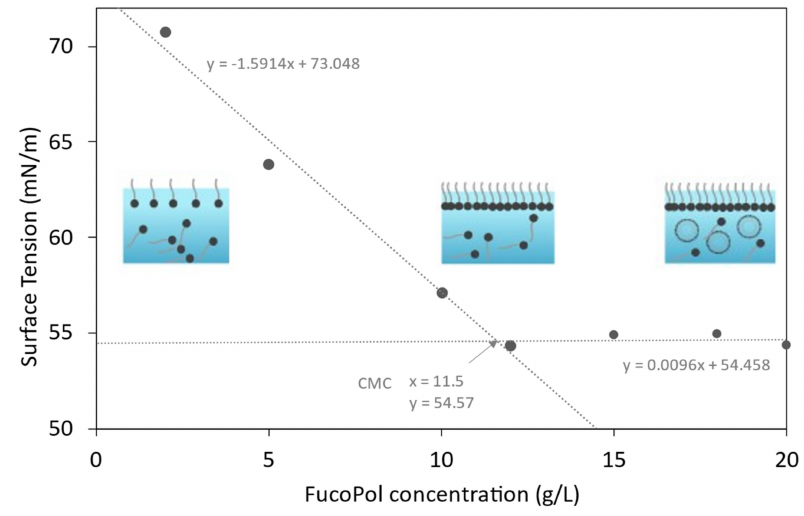
Figure 1. Surface tension of FucoPol solutions at concentrations ranging from 1 to 20 g/L.